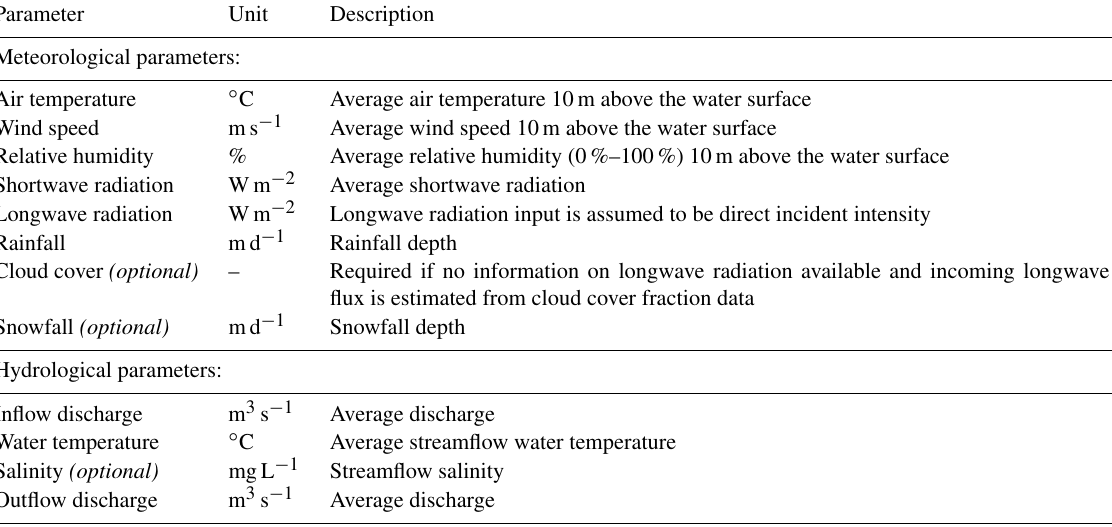
Table A1. Required model input data (after Hipsey et al., 2014). Parameter